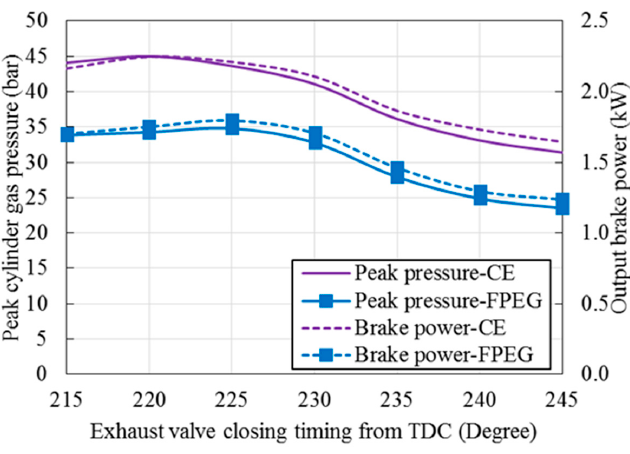
Figure 13. Engine-indicated power and peak pressure with different exhaust valve closing (EVC) timings.